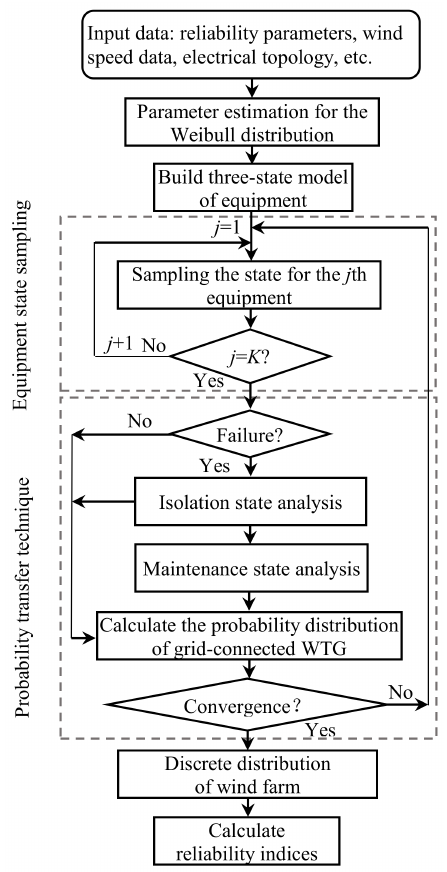
Figure 4. Flowchart for reliability assessment of wind farm electrical system.